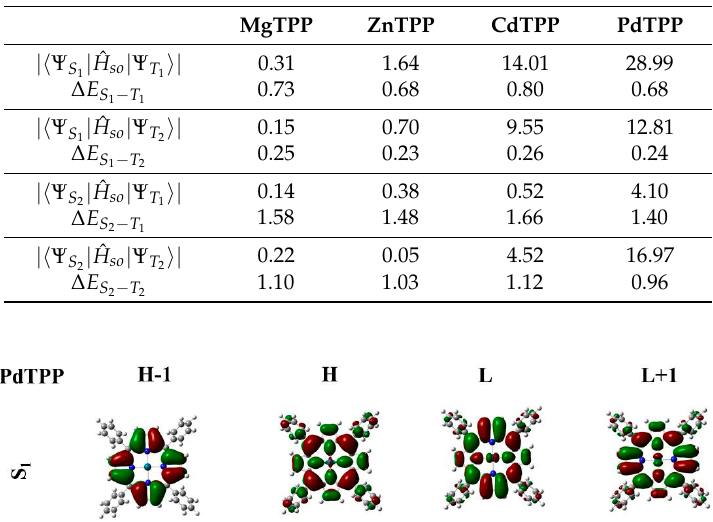
eV) between the involved excited states n − T m